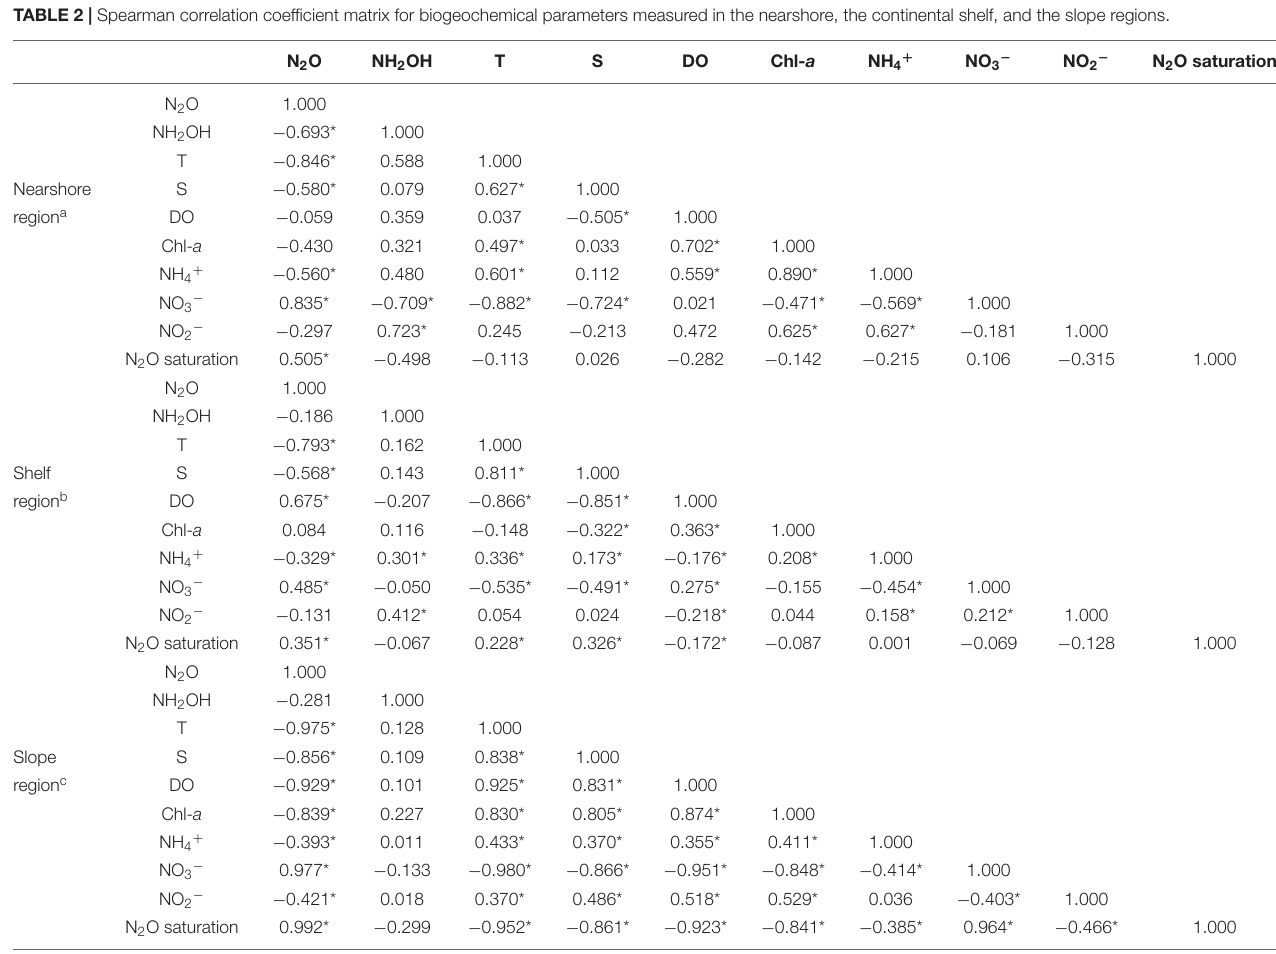
TABLE 2 | Spearman correlation coefficient matrix for biogeochemical parameters measured in the nearshore, the continental shelf, and the slope regions. N 2 O